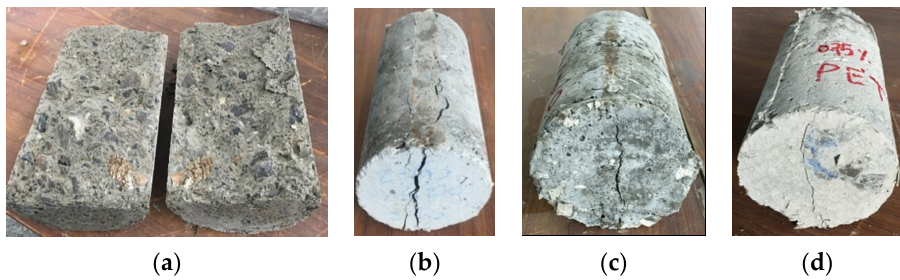
Figure 22. Cracking mechanisms after the split tensile test. ( a ) Reference, ( b ) 0.25%, ( c ) 0.5%, and ( d ) 0.75% .